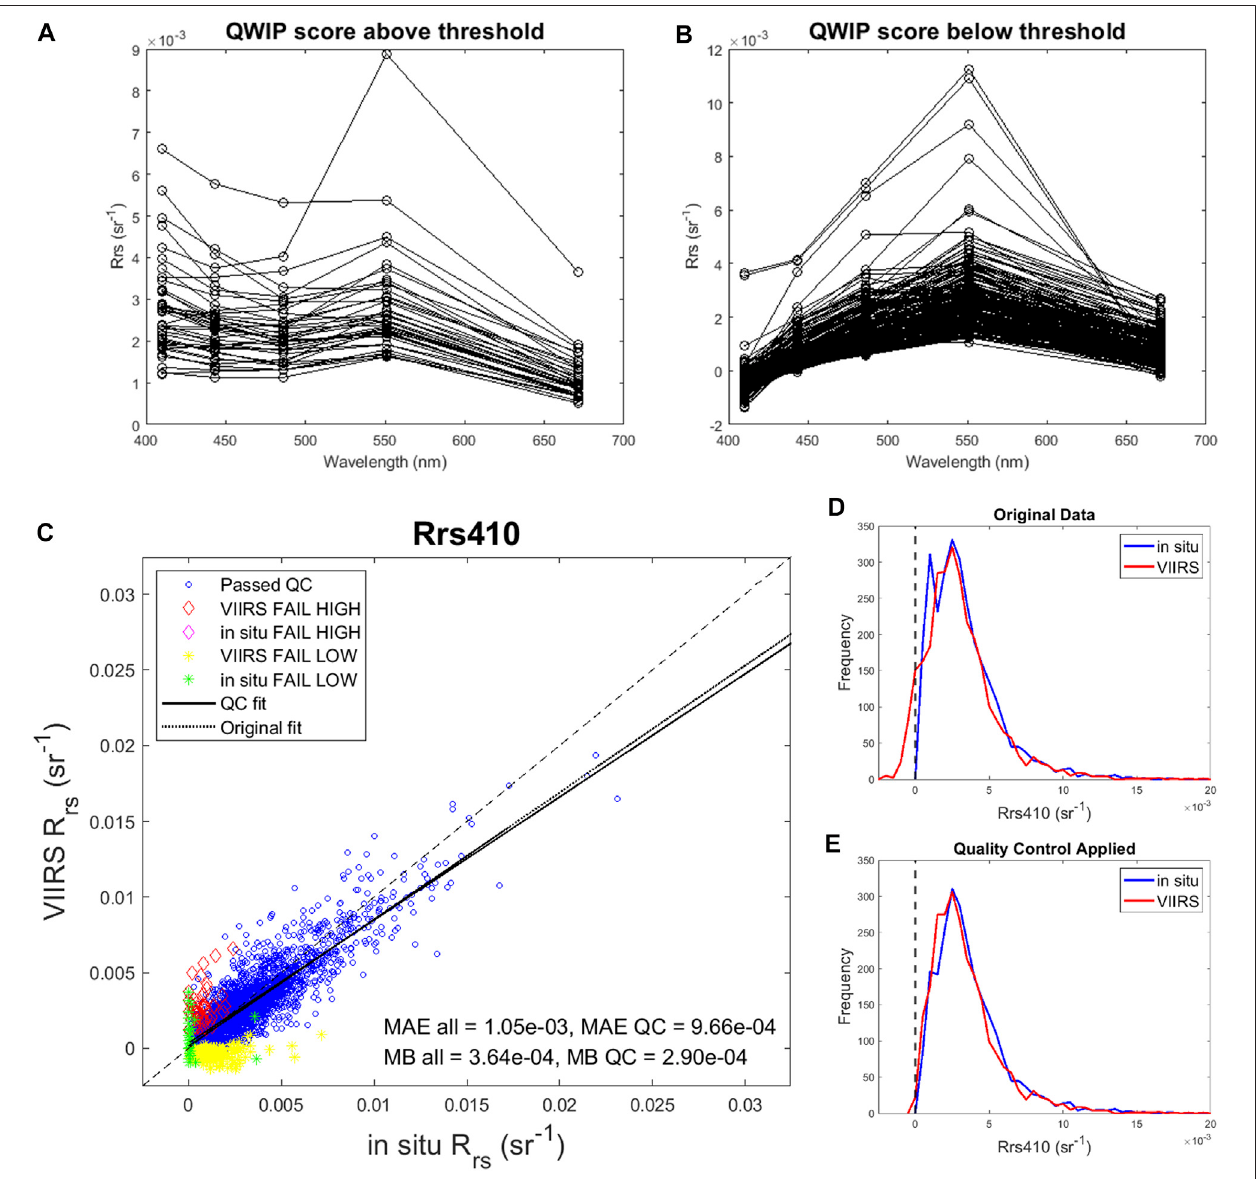
FIGURE12| Remotesensingre fl ectance( R rs )estimatedfromSNPP-VIIRSthat (A) exceededand (B) fellbelowanominalQWIPscoreof0.3. (C) Scatterplotof R rs (410) for in situ obtained from the SeaBASS archive compared to matchup data retrieved from VIIRS imagery. Blue dots represent passing data with QWIP scores less than±0.3.Amodestreductioninmeanabsoluteerrorandmeanbiasbetween insitu andVIIRSmeasurementswasfoundwhenonlypassingvalues(bluedots)areused. (D,E) The frequency distribution of data improves after the removal of those spectra fl agged by the QWIP approach.